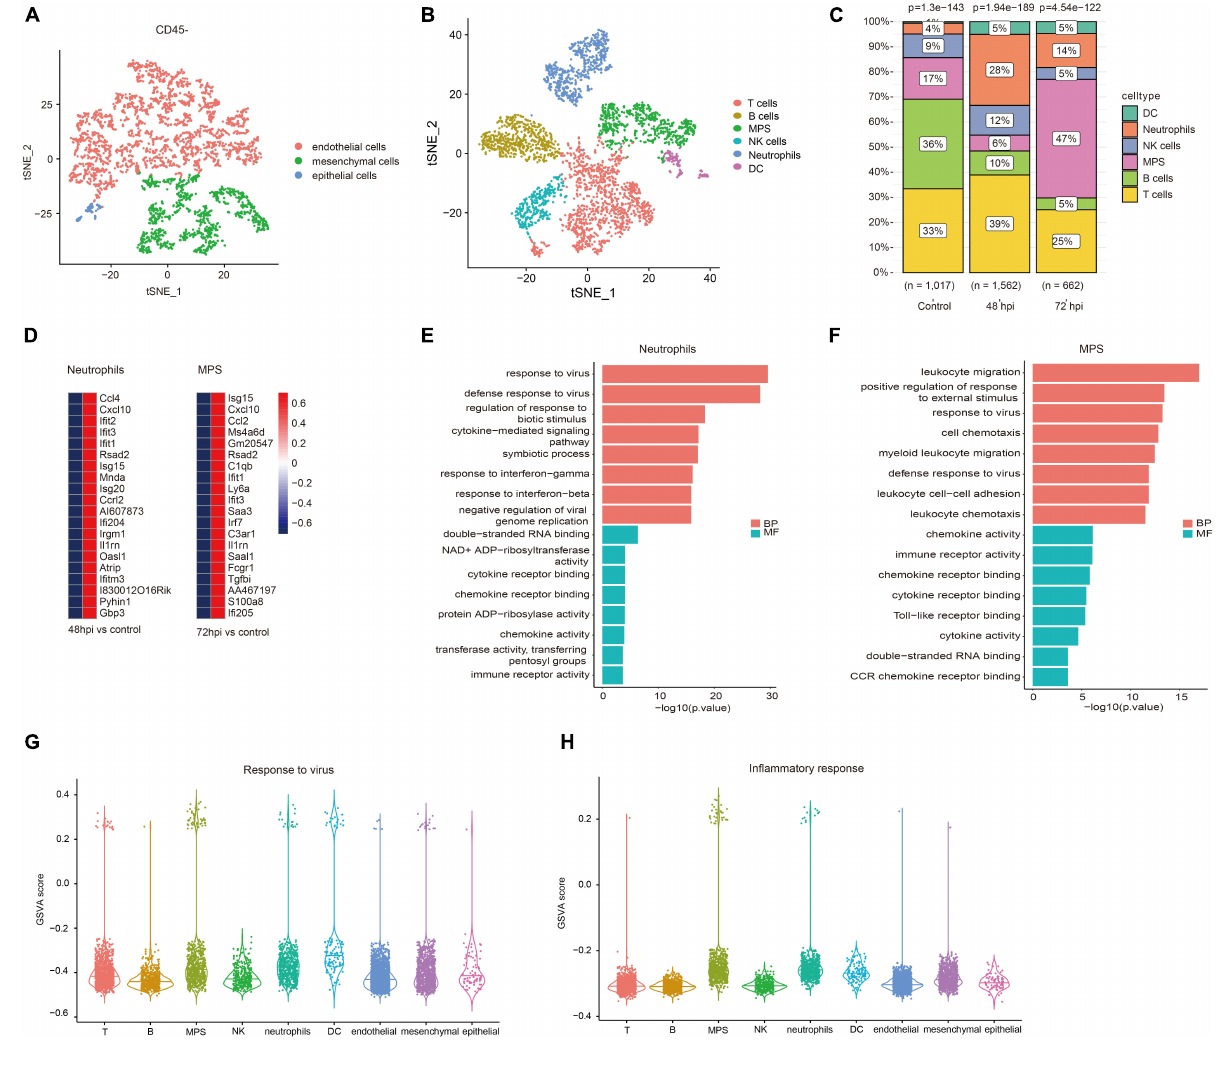
FIGURE 1 | Immune landscape associated with IAV infection. Cellular subsets from CD45- (A) and CD45 + (B) cells in the lung (GSE107947). (C) Proportions of immune cells clusters in different studied subjects. (D) Top 20 upregulated genes of neutrophils at 48 hpi and MPS at 72 hpi. (E) Top eight GO terms of BP and MF in neutrophils. (F) Top eight GO terms of BP and MF in MPS. GSVA scores of response to virus (G) and inflammatory response (H) in different cell